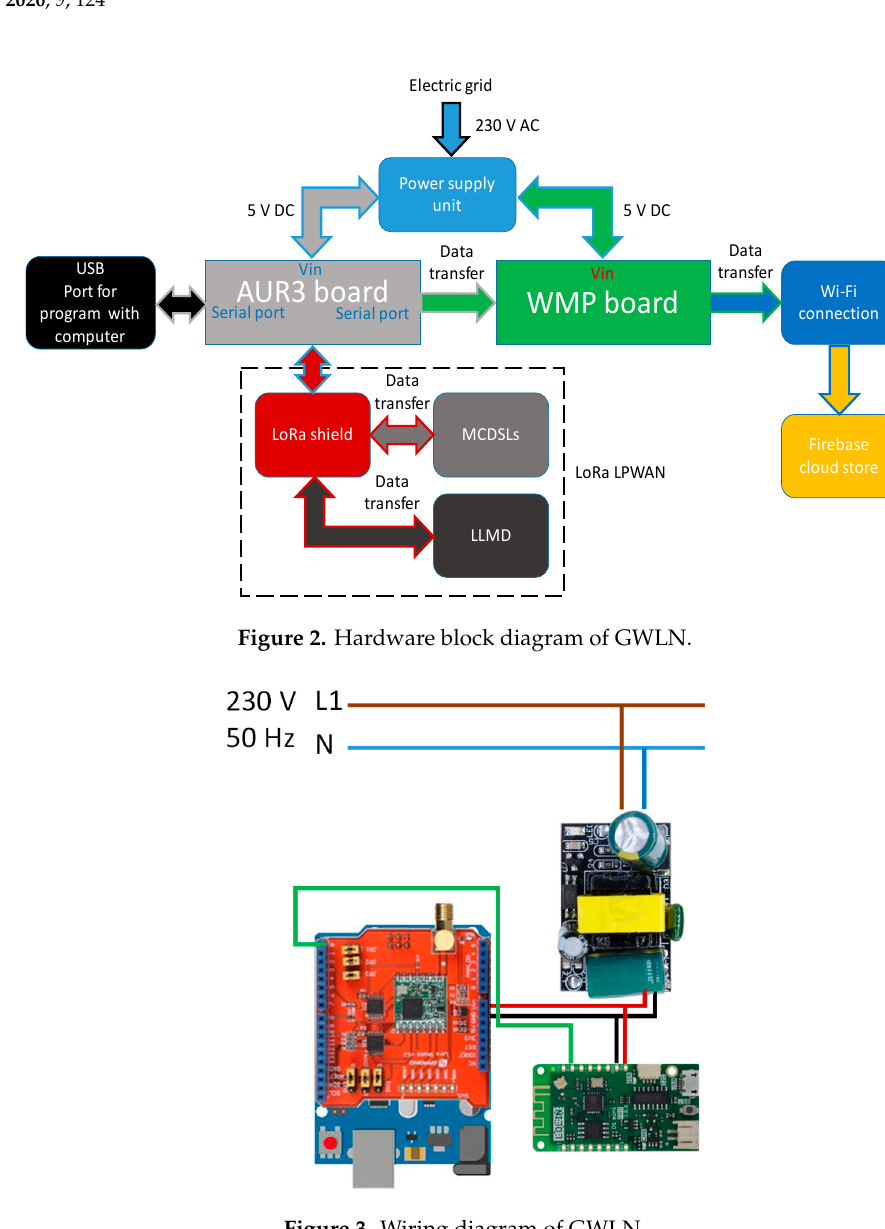
Figure 3. Wiring diagram of GWLN. Table 3. GWLN components cost.